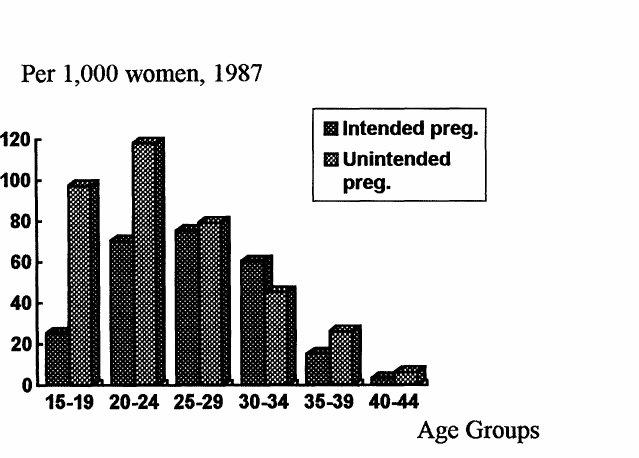
FIGURE 5 Most pregnancies in women under 24 or over 35 are unintended. (Reprinted with permission from Alan Guttmacher